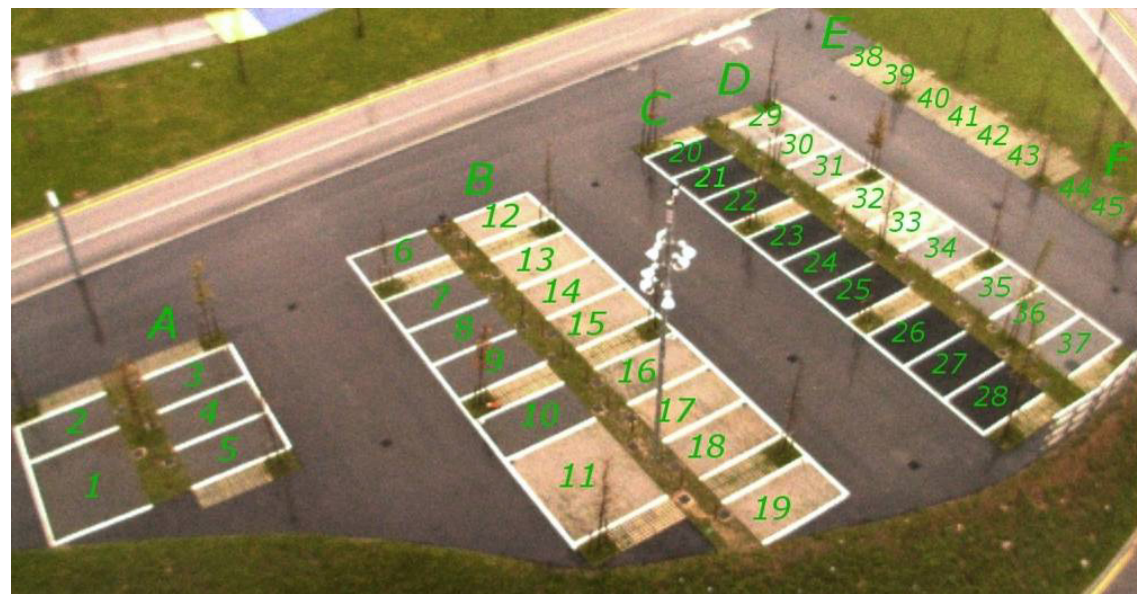
Figure 11. Las Llamas experimental car park